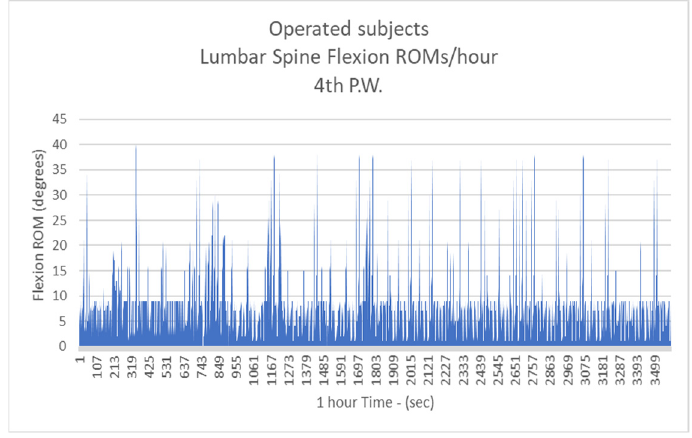
Figure 8. The number of more than 10 degrees of Lumbar Spine Flexions (LSFs) per hour for operated subjects at the 4th postoperative week.